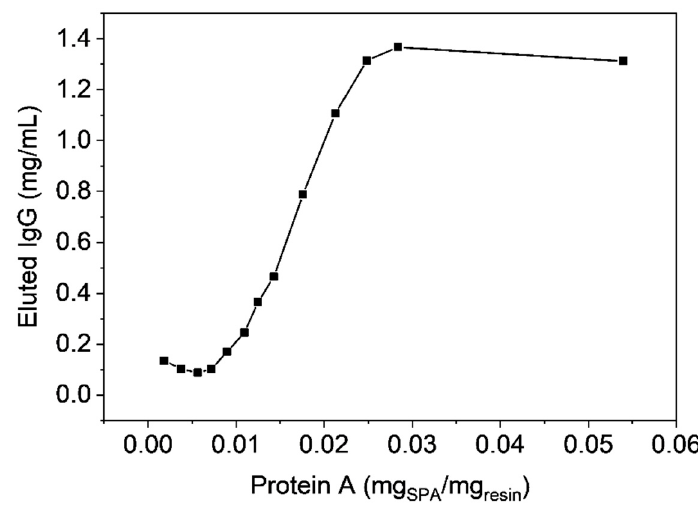
per Figure 10. Static binding capacities determined for samples with different amounts of protein A per resin.